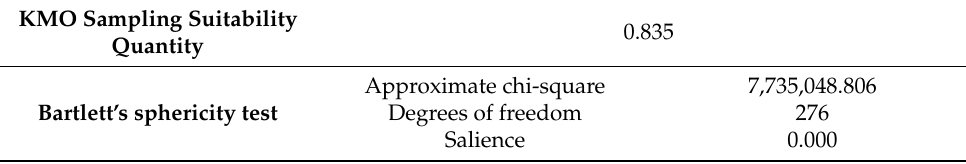
Table 3. KMO and Bartlett test of the vehicle driving experimental data.